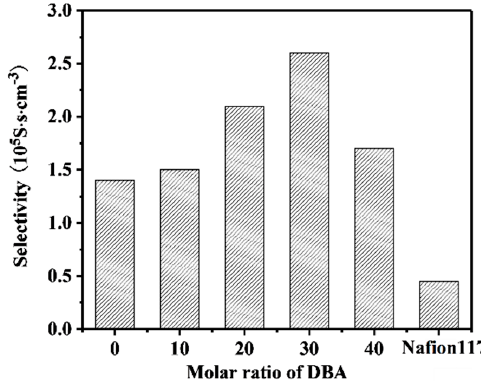
Figure 11. The selectivity of CSPEN-60-DBA-x at different temperatures.